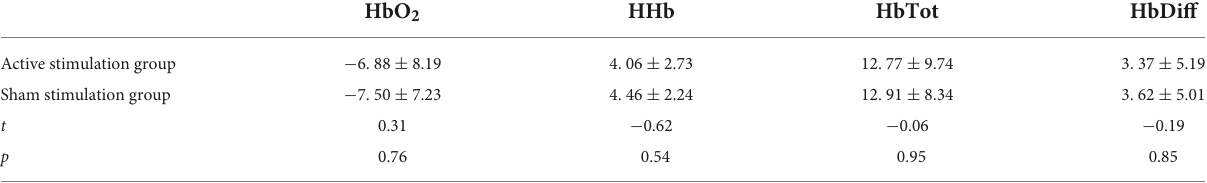
TABLE 4 Analysis of baseline data of oxygenated hemoglobin in two groups.